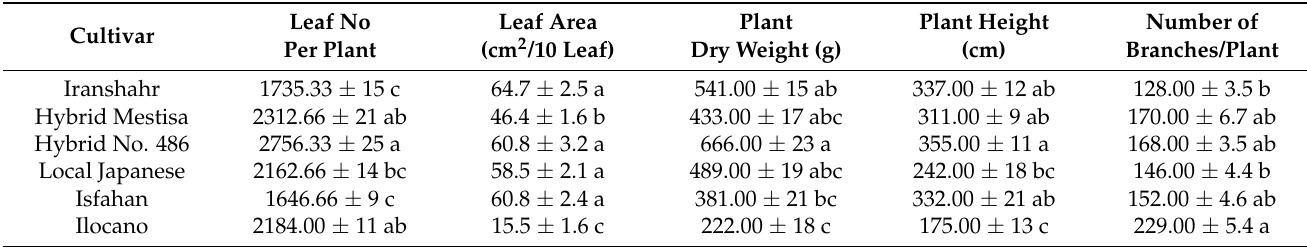
Table 1. Mean comparison of vegetative traits of six bitter melon cultivars.